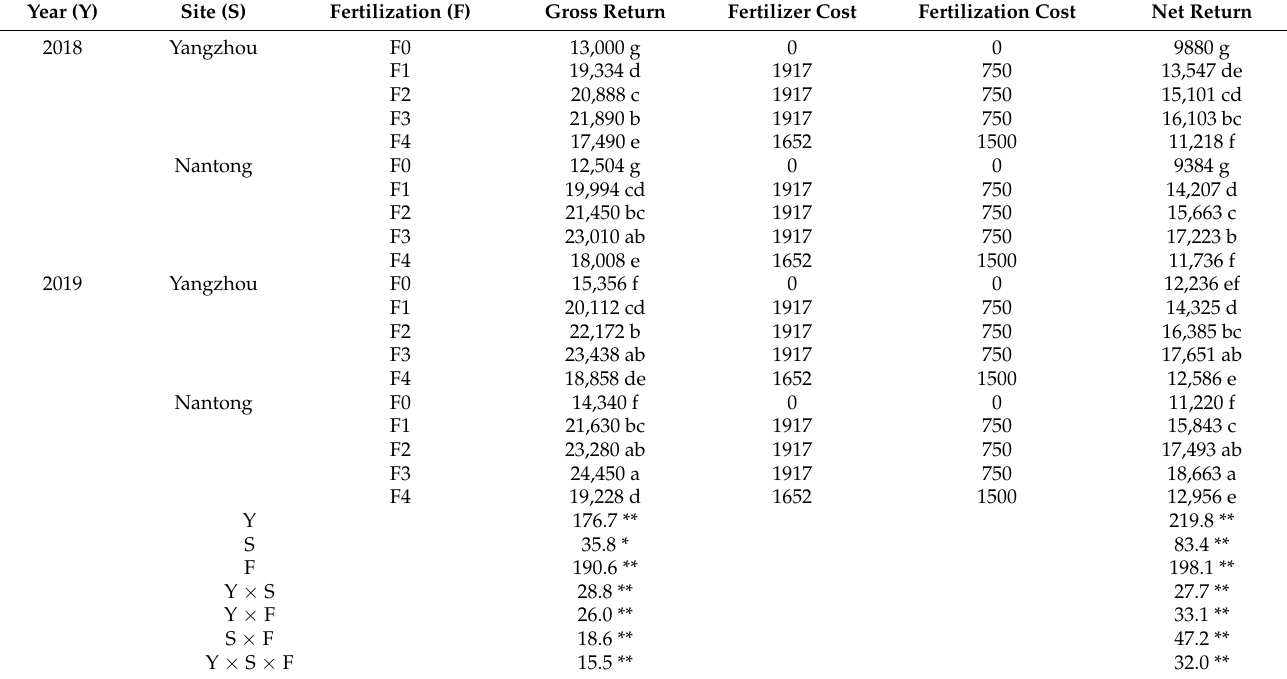
Table 3. Economic analysis (CNY ha − 1 ) related to fertilization methods in 2018 and